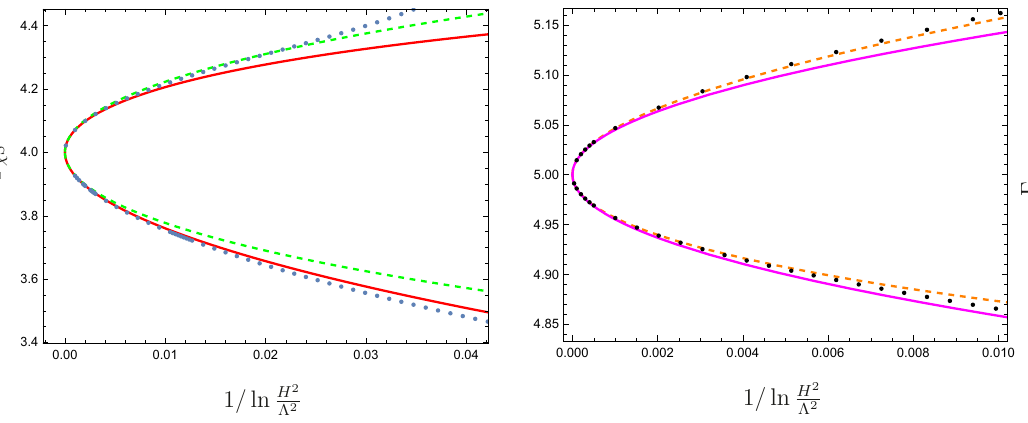
(4.6), represented by crit 3